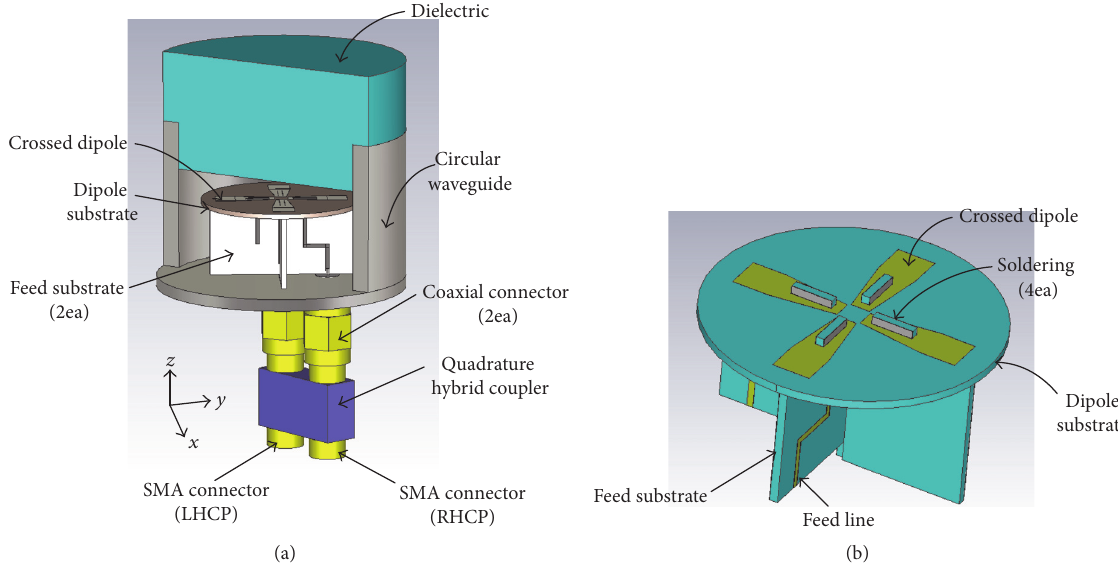
Figure 1: Structure of the proposed feed. (a) Overall structure and (b) crossed dipoles with associated feed circuits.